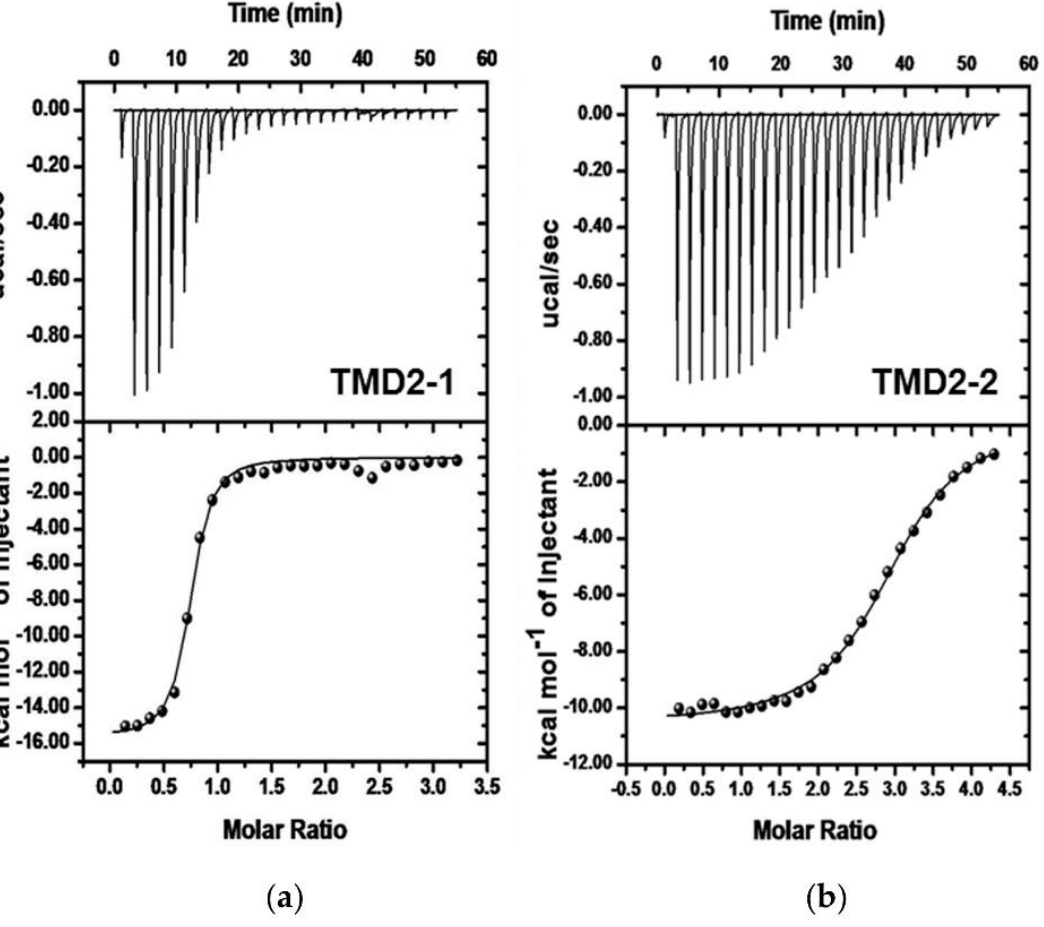
Figure 2. ITC profiles of ( a ) 50 µ M peptides TMD2-1 and ( b ) TMD2-2 in 10 mM SDS micelles at pH 6 titrated with AgNO 3 . Figure adapted with permission from reference [59]. Copyright 2015 American Chemical Society.